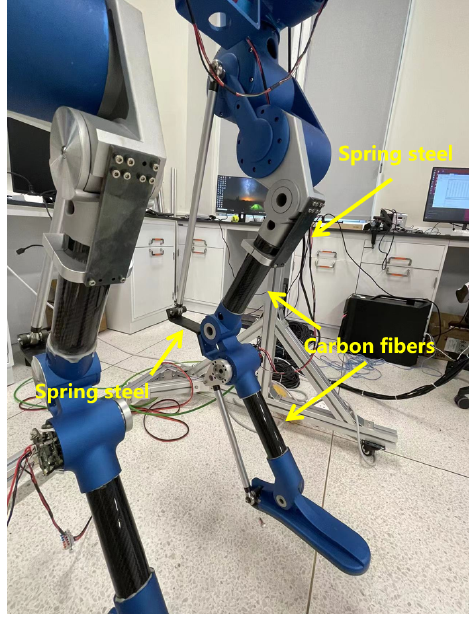
Figure 7. Inside view of experimental